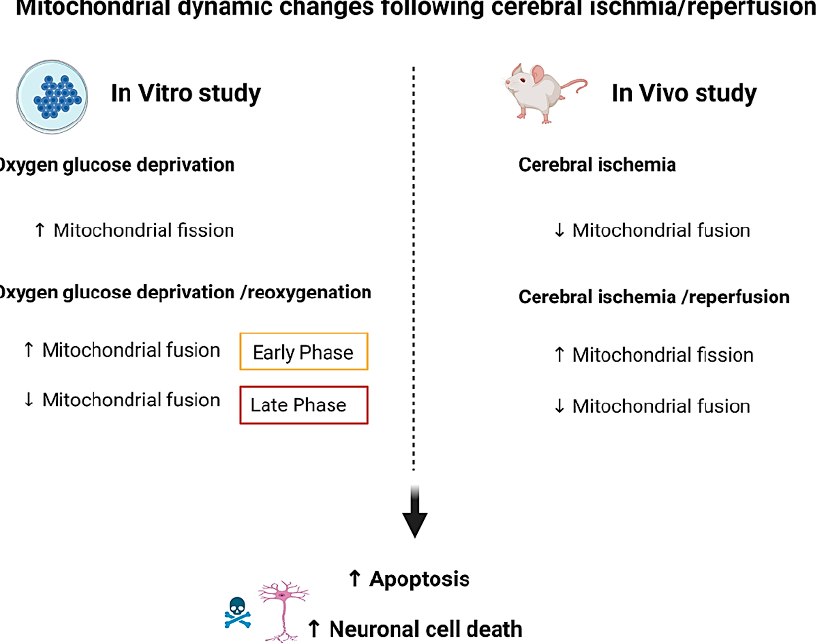
Figure 3. The differences in mitochondrial dynamic alteration after ischemia with or without reperfusion (both in vitro and in vivo studies). In in vitro studies, an increase in mitochondrial fission occurred in OGD (ischemic) condition. Mitochondrial fusion was increased during the early phase of OGD/reoxygenation and decreased after late phase of OGD/reoxygenation. In in vivo studies, a decrease in mitochondrial fusion occurred in cerebral ischemia. An increase in mitochondrial fission and the reduction in mitochondrial fusion were observed after cerebral ischemia/reperfusion. These impaired mitochondrial dynamics caused brain apoptosis and consequently caused neuronal cell death. OGD, oxygen glucose deprivation . (This figure was created with BioRender.com).